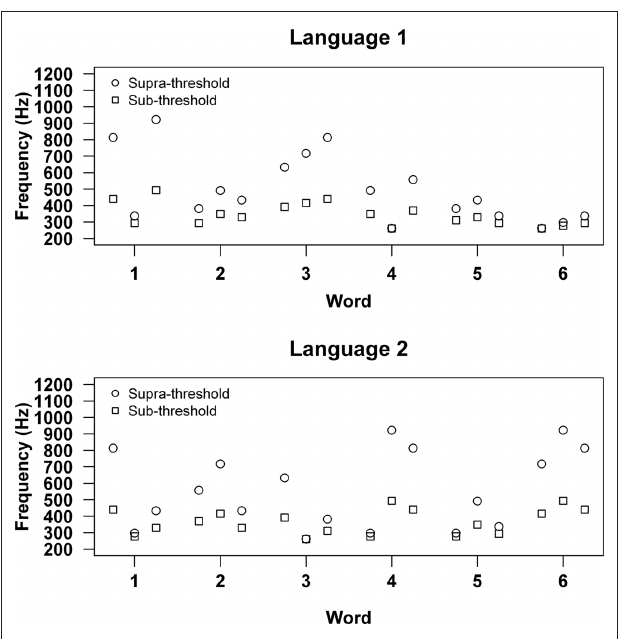
FiGuRe 2 | Tone words used in language 1 and language 2 for the sub-threshold and supra-threshold tonal conditions. For the